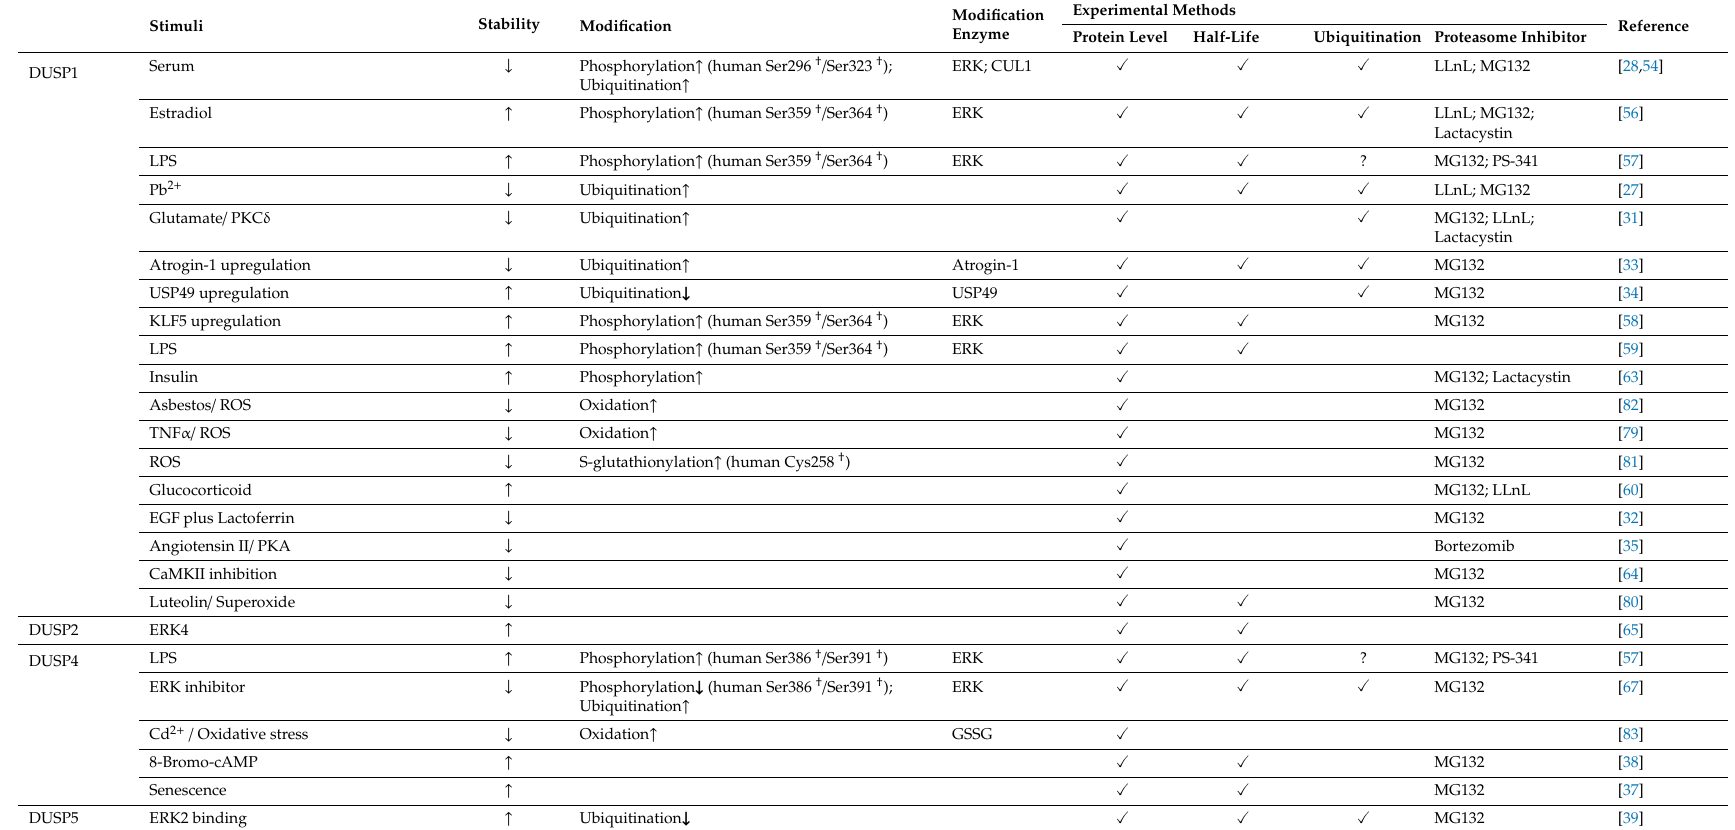
Table 2. Regulation of DUSP protein stability or phosphatase